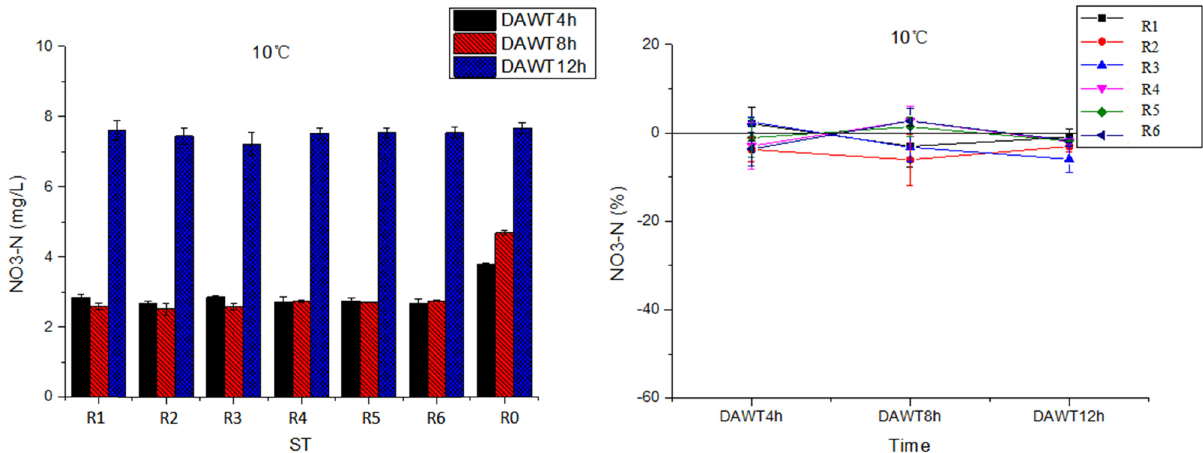
Figure 3: NO 3 – N varies with